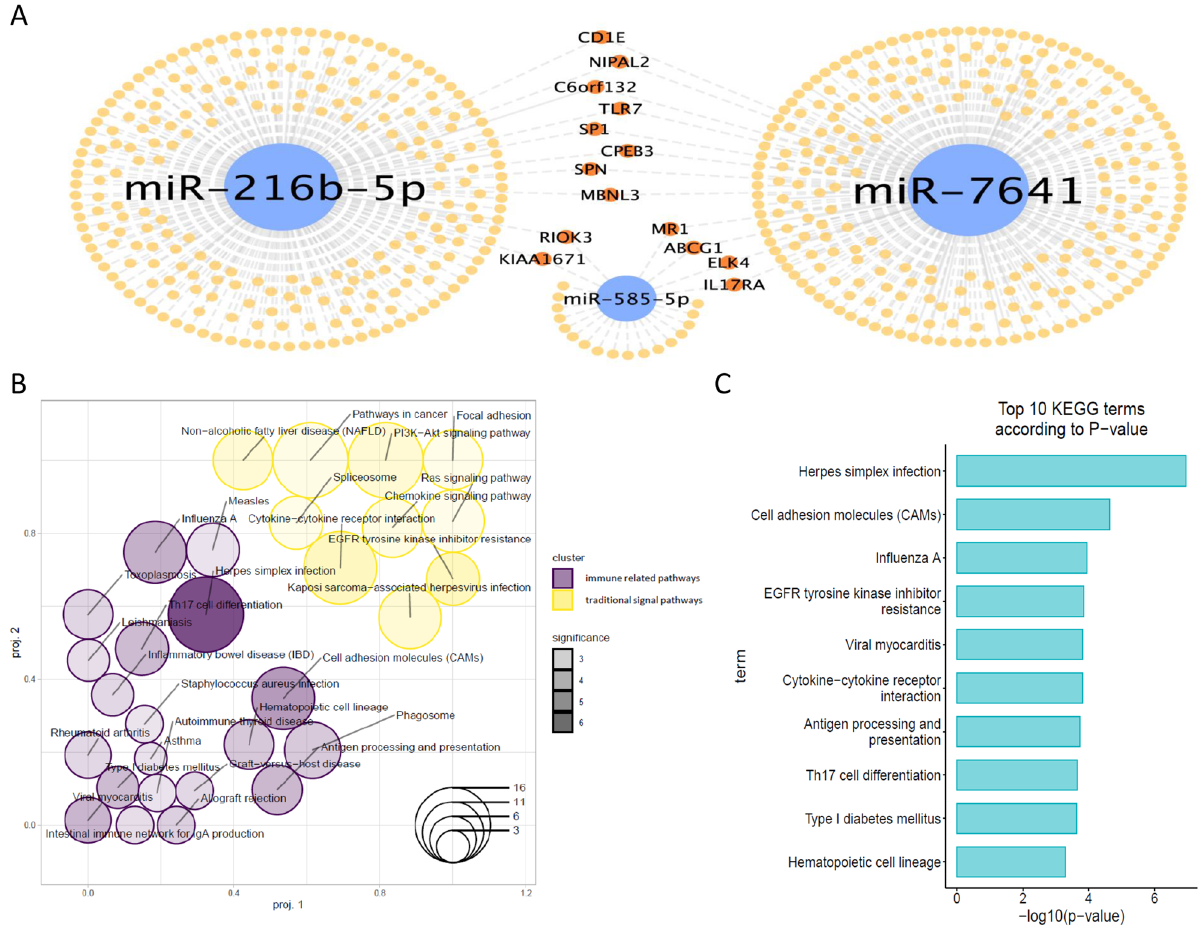
Figure 4. Target gene interaction and functional enrichment. (A) The collaborative network displaying the interactions between the 3 candidate miRNAs and the targeted genes. (B) A gene set overrepresentation of the top 30 significant KEGG pathways. (C) The top 10 significant enriched KEGG pathways of the target